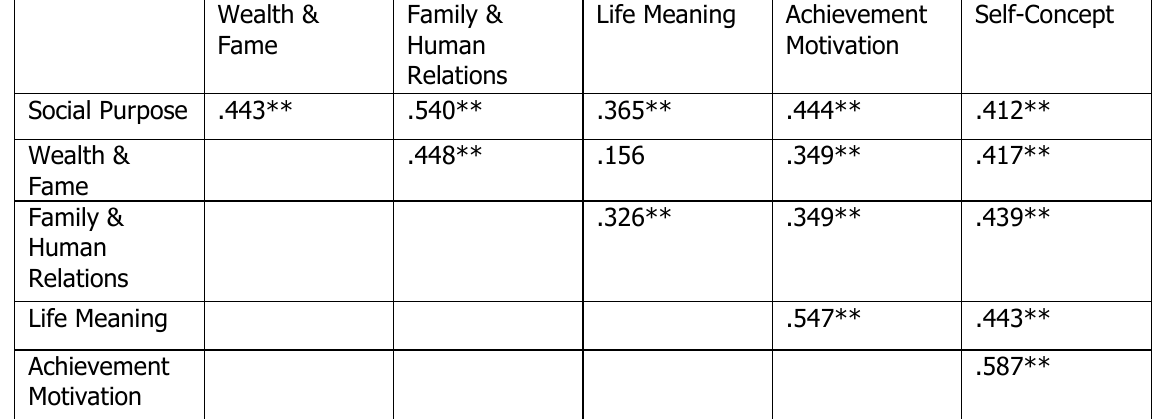
Correlations among the goal types and the criterion measures (n =